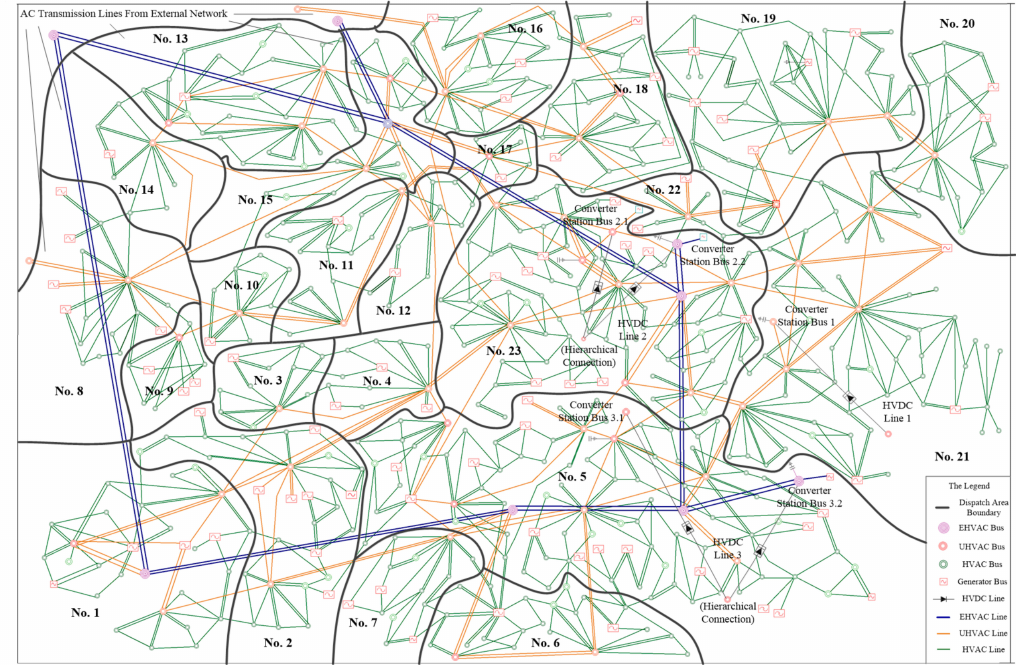
Figure 9. Recovered dispatch areas of the test system.